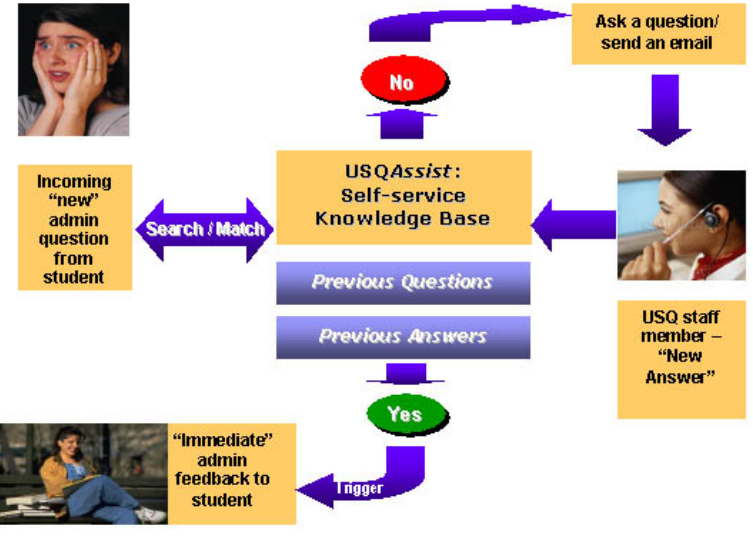
Figure 8. Schematic Representation of